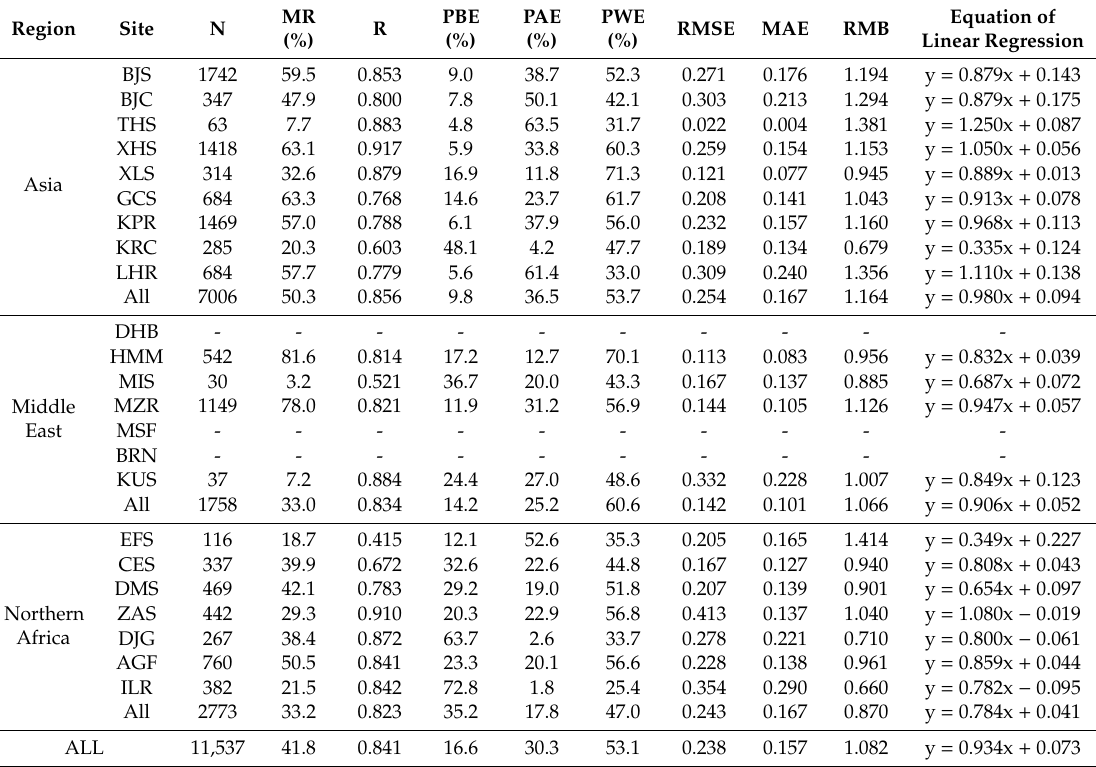
Table 4. Statistical summary for validation of MOD04 DT / DB AOD